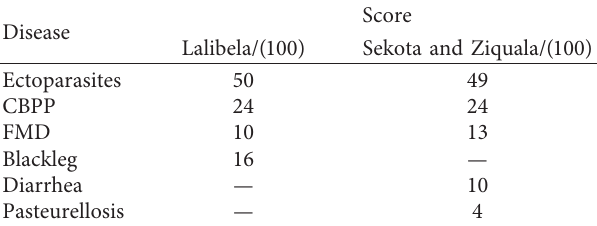
Table 1: Disease priority scores in the study districts.